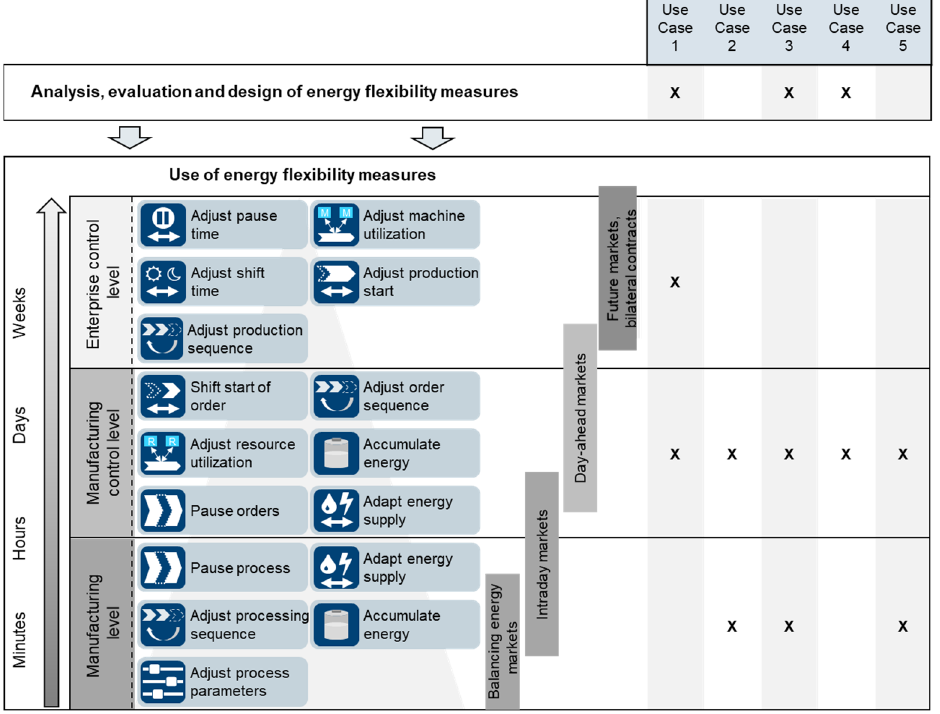
Figure 3. Energy flexibility measures allocated to their levels of implementation in the energy-flexible factory and their corresponding marketing opportunities ( left ), coverage of the conducted use cases ( right ) (own illustration based on [10,14,15]).